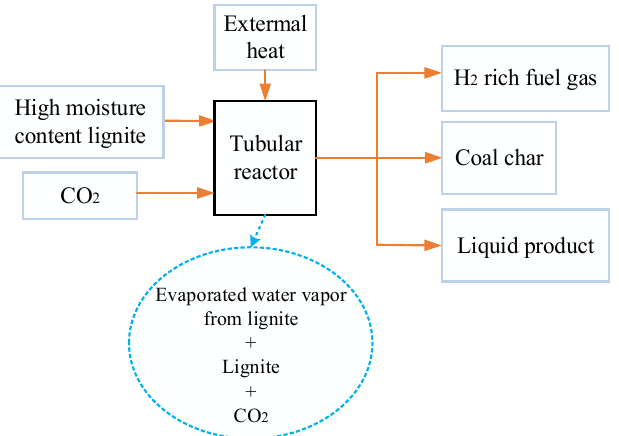
Figure 2. Schematic of the high moisture content lignite gasification under a CO 2